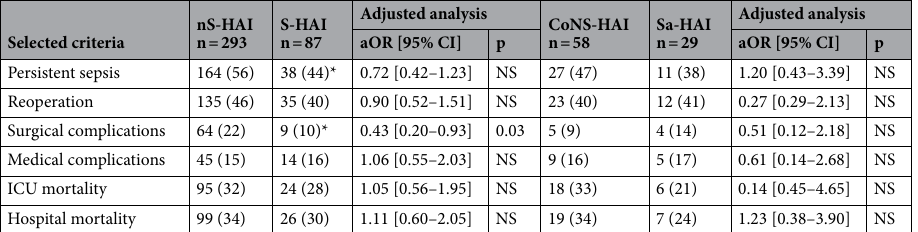
Table 4. Secondary outcomes of the four groups of patients with HAI. HAI Hospital-acquired postoperative intra-abdominal infection, nS-HAI infection without staphylococci peritoneal cultures, S-HAI infection with staphylococci peritoneal cultures, ICU intensive care unit, OR odds ratio, aOR odds ratio adjusted to age, sex, and SOFA score at the time of reoperation; adequacy of empirical anti-infective therapy; and the year of inclusion, CI confidence interval, NS non-significant; *p < 0.05 between the nS-HAI and S-HAI